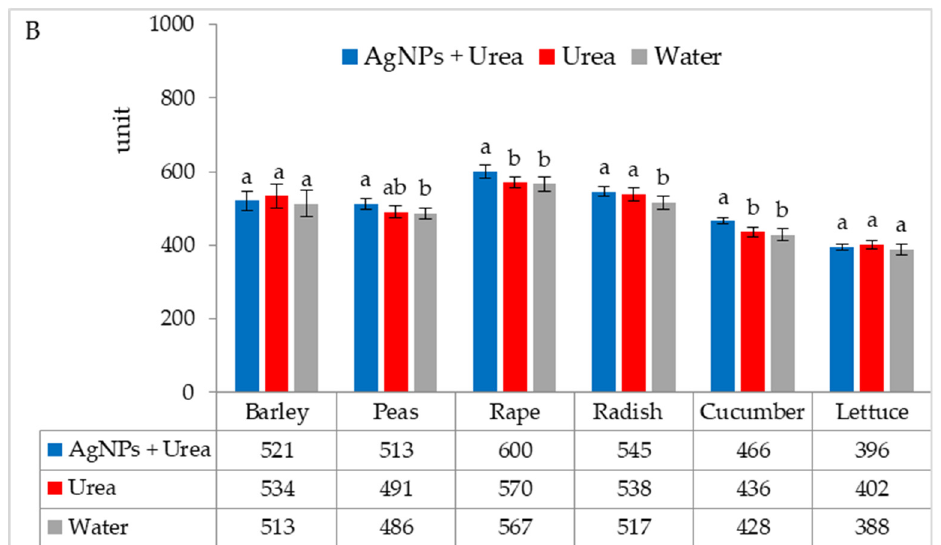
Figure 2. Chlorophyll content in leaves under optimal—( A ) and thermal stress conditions—( B ) de- pending on the presence of AgNPs in the substrate; urea solution with AgNPs (AgNPs + Urea), urea solution (Urea), water (Water). a, b—letters indicate a significant difference in the content of chlorophyll for individual plant species at p < 0.05.